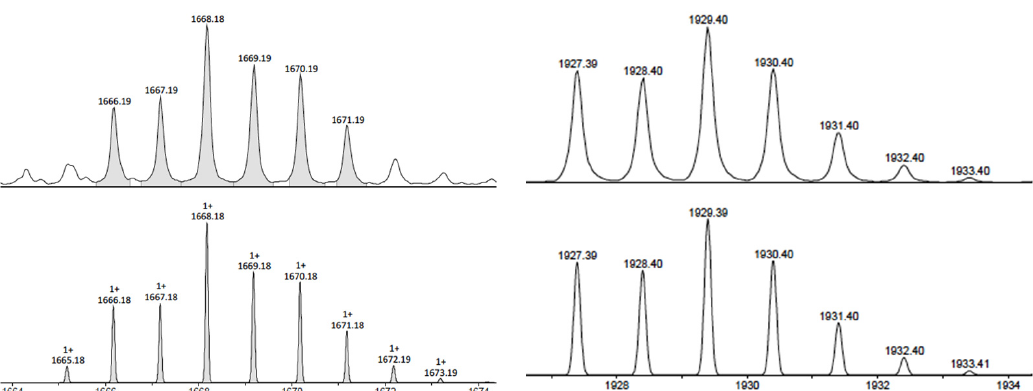
Figure 2. Mass spectrum (ESI-TOF) of silver complexes; observed spectrum ( Top ) and simulated spectrum (Bottom) for: (C 20 H 21 O 4 N 3 PF 3 ) 3 Ag 2 BF 4 (Left) and (C 20 H 21 O 4 N 3 PF 3 ) 4 Ag (Right).